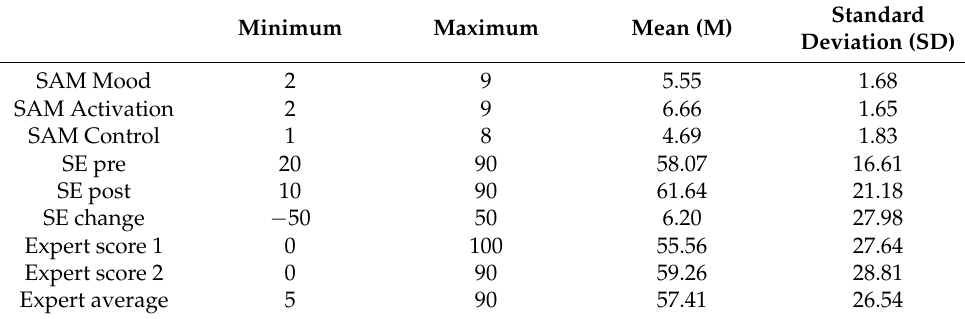
Table 2. Descriptive statistics of SAM, SE, and Expert ratings. Minimum